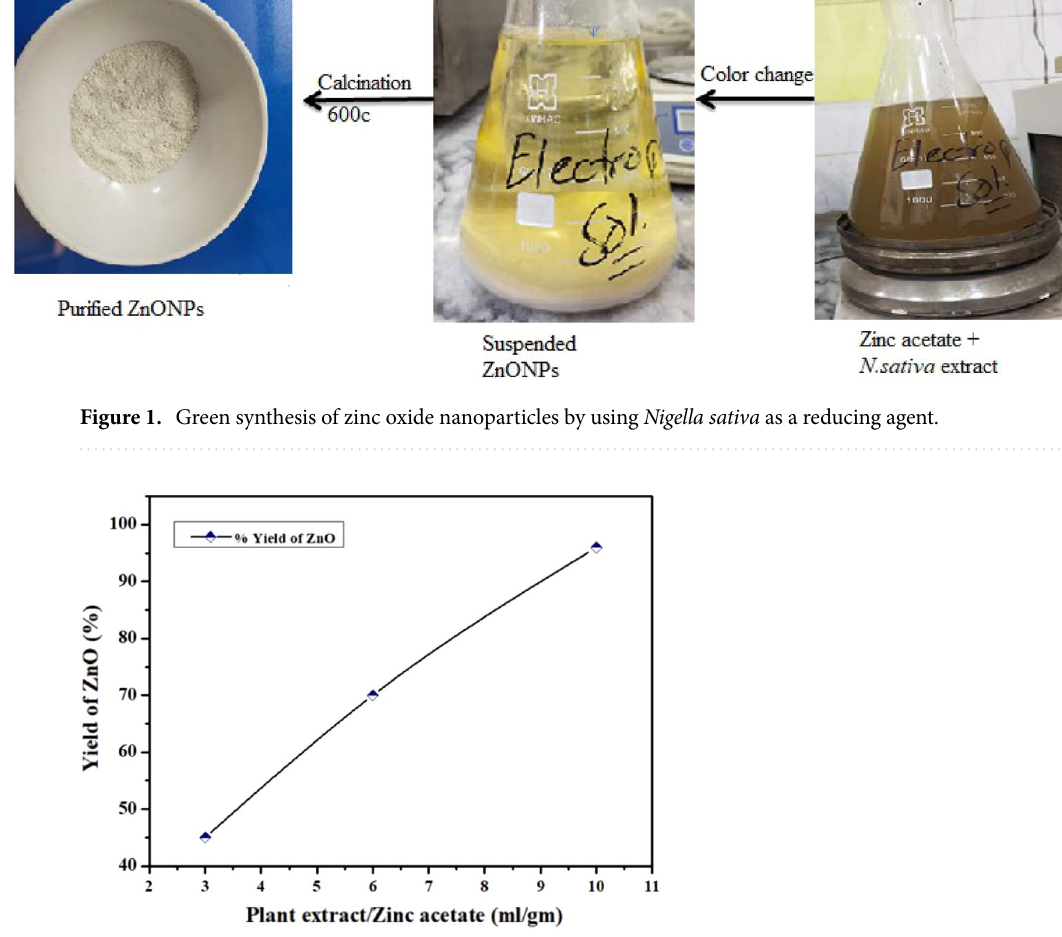
Figure 2. Effect of the plant extract to Zinc acetate ration (v/w) on yield (%) of Biosynthesized